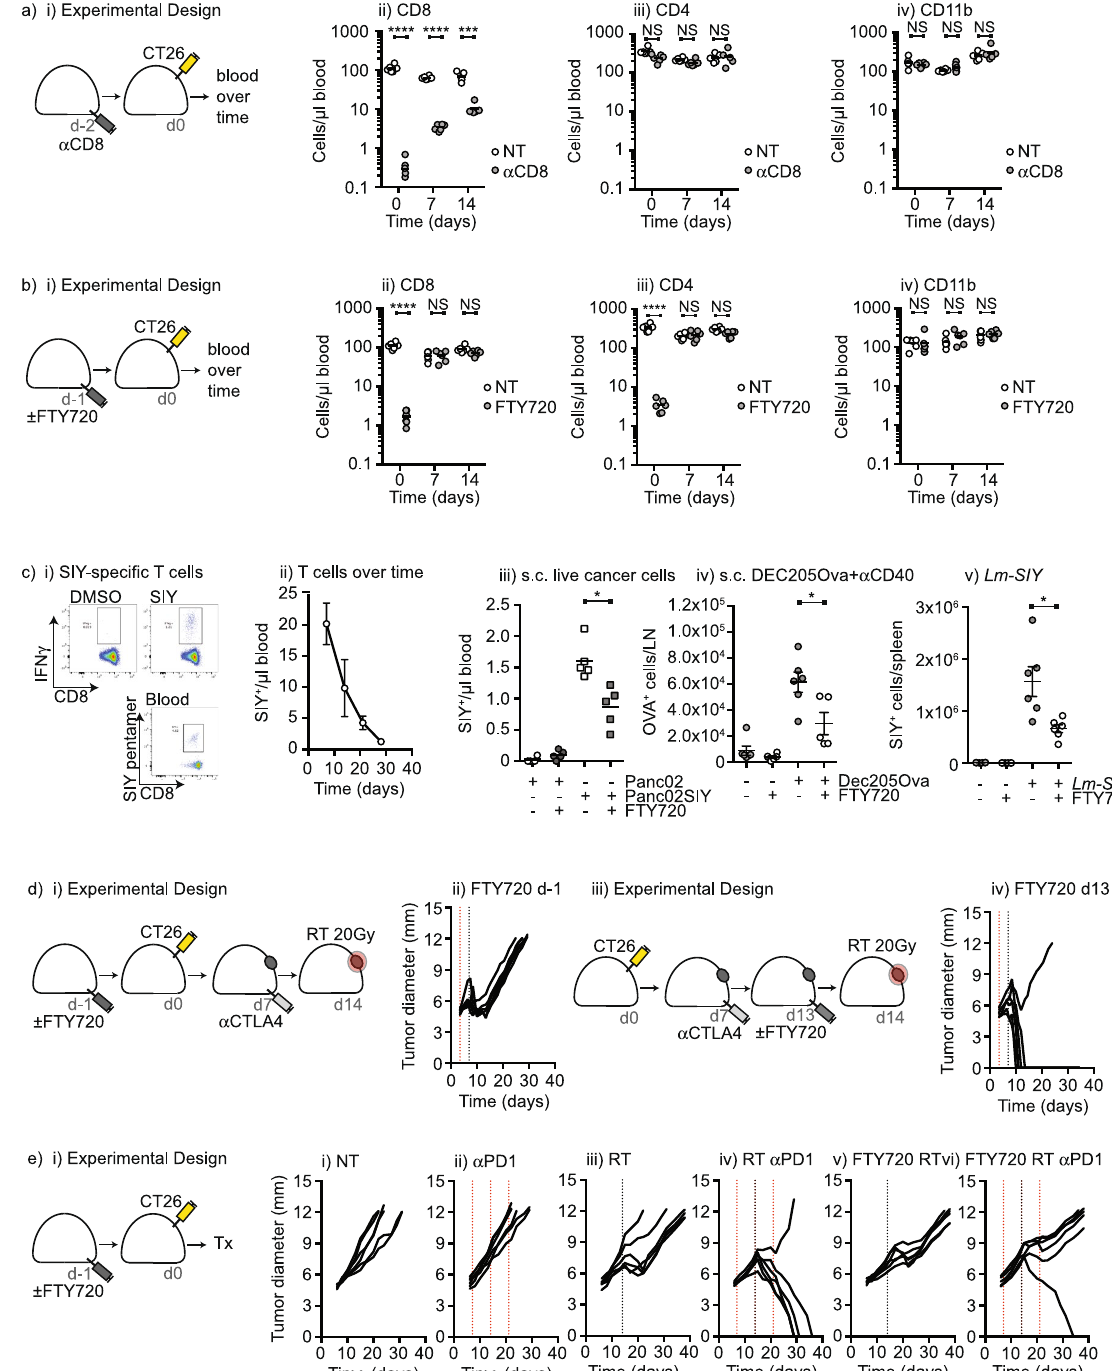
Figure 2. FTY-720 immunosuppression at tumor implantation eliminates tumor control by subsequent radiation therapy and checkpoint inhibition. ( a ) BALB/c mice were randomized to receive CD8 depleting antibodies 2 days prior to implantation with CT26 tumors. Graphs show quantitative analysis of i) CD8 + , ii) CD4 + and iii) CD11b + cells over time following CD8 depletion. ( b ) i) BALB/c mice were randomized to receive FTY-720 1day prior to implantation with CT26 tumors. Graphs show quantitative analysis of ii) CD8 + , iii) CD4 + and iv) CD11b + cells over time following FTY-720 administration. ( c ) i) C57BL/6 mice were implanted with Panc02-SIY tumors and analyzed for SIY-specific T cells in the spleen by ICS for IFN γ , or in the blood using an SIY-pentamer. ii) Time course of the SIY-specific response in the peripheral blood of mice implanted with Panc02-SIY through tumor growth. Mice were randomized to treatment with FTY-720 or left untreated, then vaccinated 1day later with iii) subcutaneous injection of Panc02-SIY, iv) subcutaneous injection of Dec205- Ova + anti-CD40, or v) intravenous administration of Lm-SIY. Graphs show antigen-specific cells in blood, LN or spleen, respectively. d) i) Mice were implanted with CT26 and treated with anti-CTLA4 on d7 and